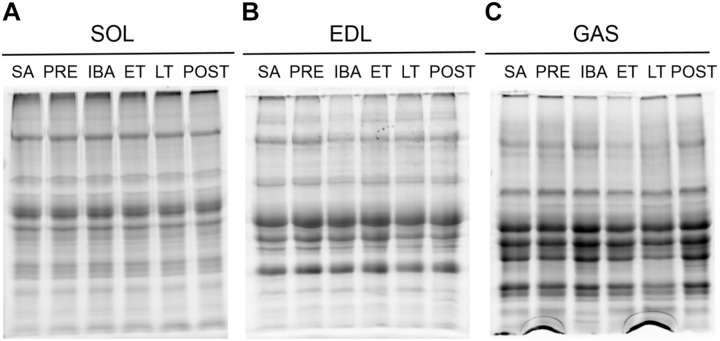
Stain-free imaging of separation gel. (A) In the SOL. (B) In the EDL. (C) In the GAS. SOL, soleus; EDL, extensor digitorum longus; GAS, gastrocnemius. SA, summer active; PRE, pre-hibernation; IBA, interbout arousal; ET, early torpor; LT, late torpor; POST, post-hibernation.